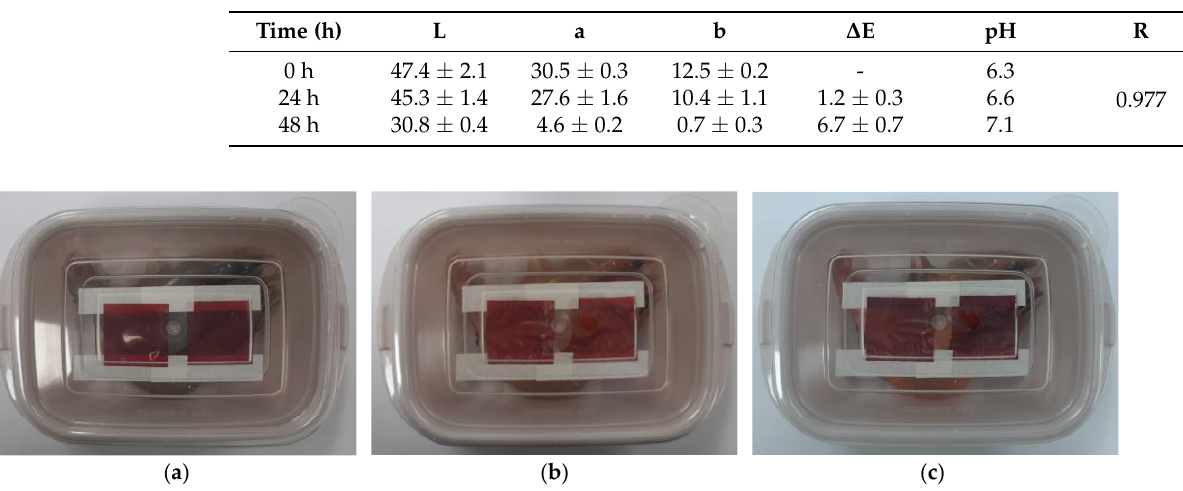
Table 3. Changes in the color values of the indicator and the pH of shrimp sample papers during storage. Correlation of ΔE of the indicator with pH during storage.